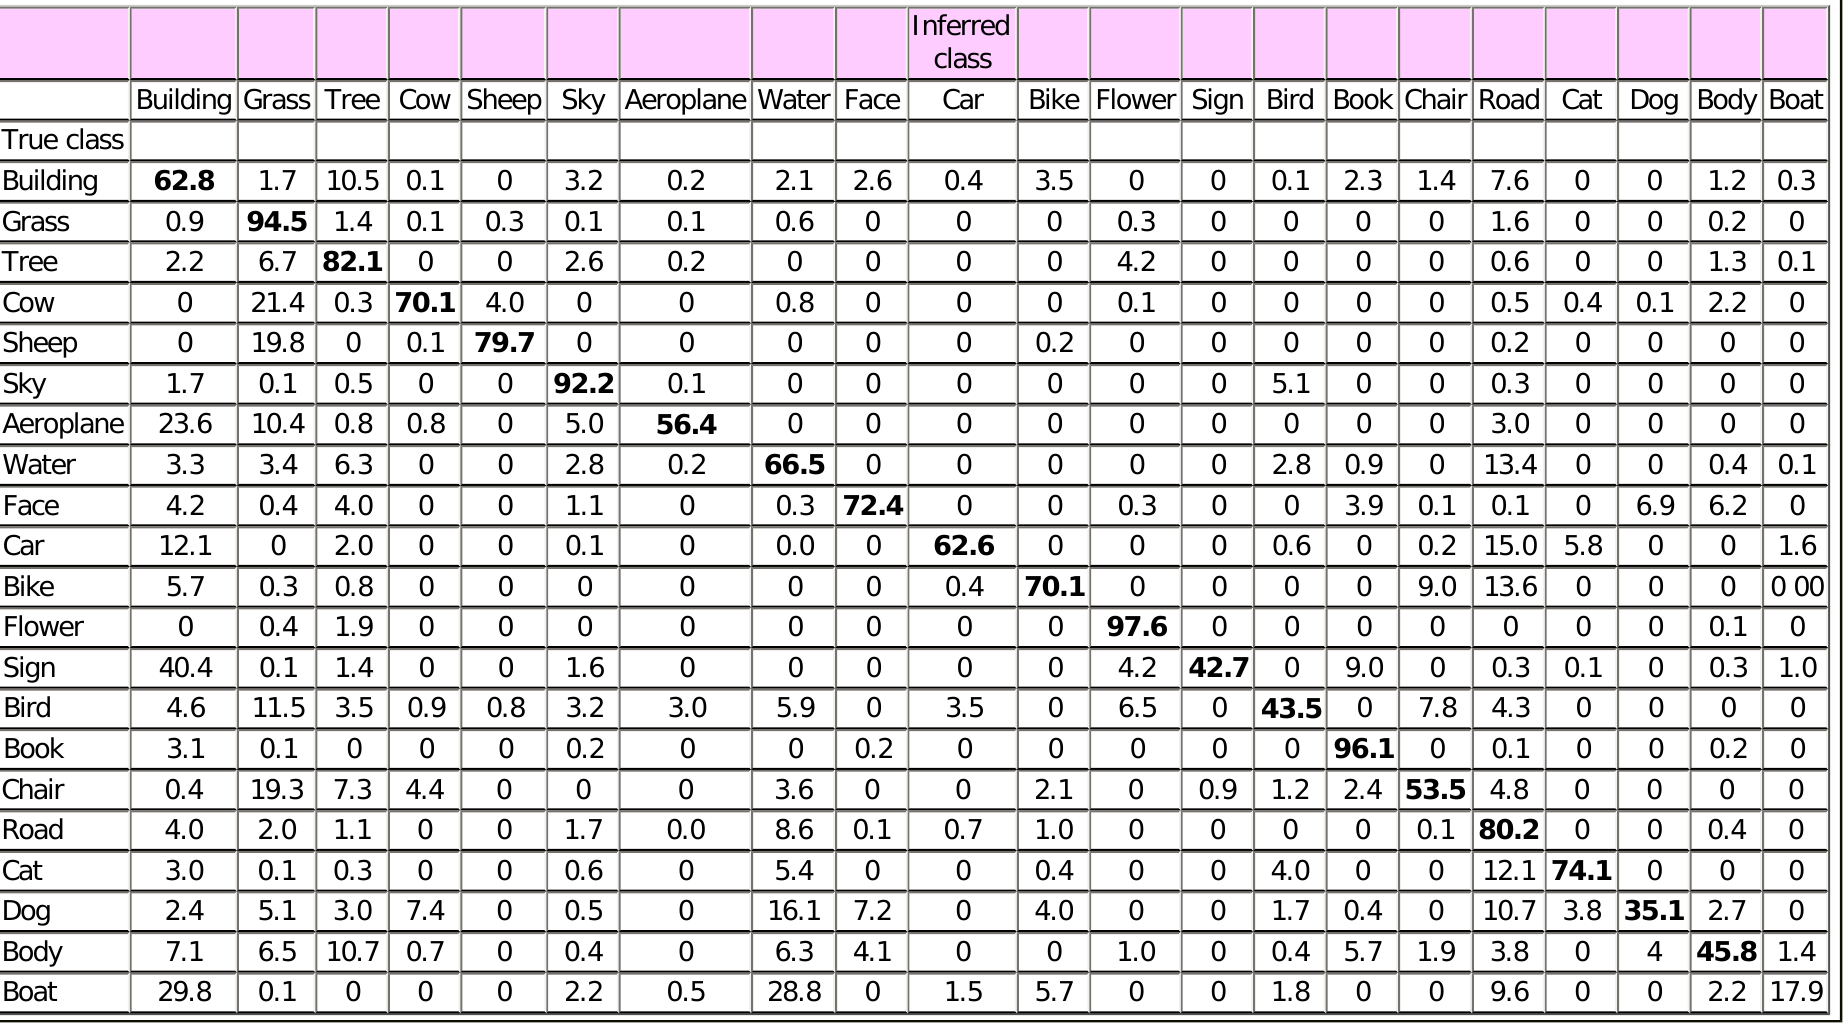
Table 2 Pixel level confusion percentages for our LRC/CRF/OS method on the MSRC-21 dataset. The mean pixel level accuracy is